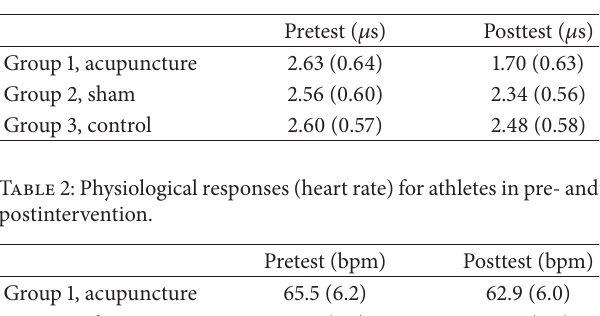
Table 1: Physiological responses (skin conductance) for athletes in pre- and postintervention.